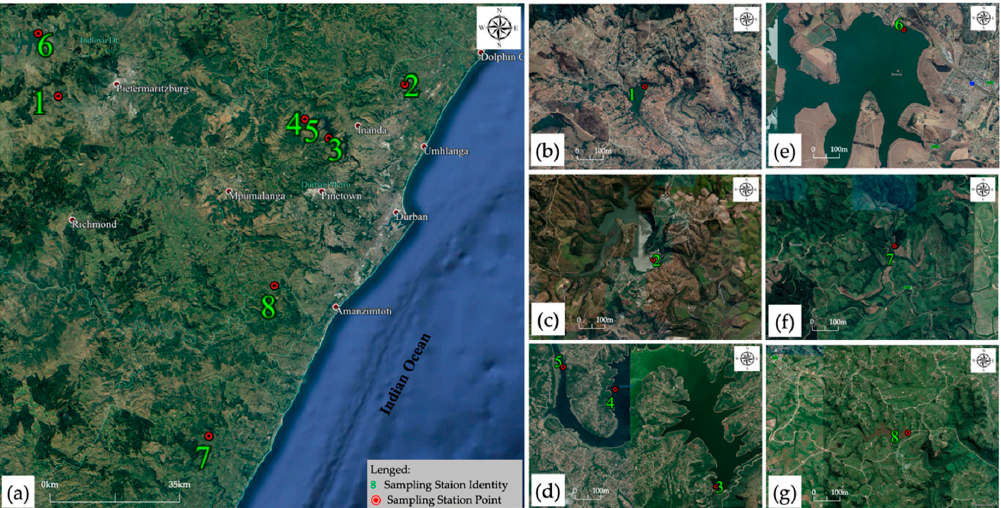
Figure 1. Locality map for sampling stations: ( a ) all eight sampling stations, ( b ) Henley Dam, ( c ) Hazelmere Dam, ( d ) Inanda Dam, ( e ) Midmar Dam, ( f ) Umzinto Dam, and ( g ) Nungwane Dam. The